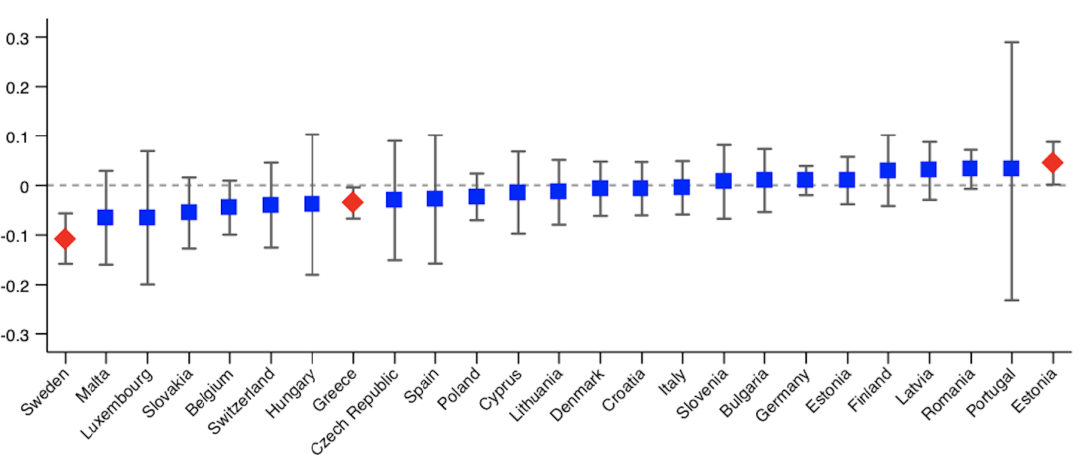
Figure 1. Erreygers’ concentration indices of income-related inequality in postponed health care during the COVID-19 pandemic across European countries. Note: red diamonds indicate p < 0.05.